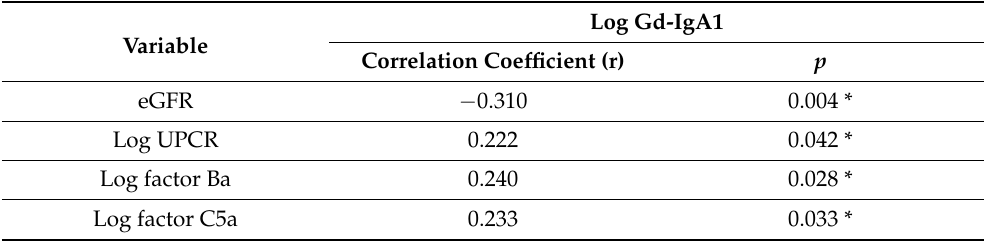
Table A1. Correlation analysis of Gd-IgA1 with clinical parameters and the levels of factor Ba and